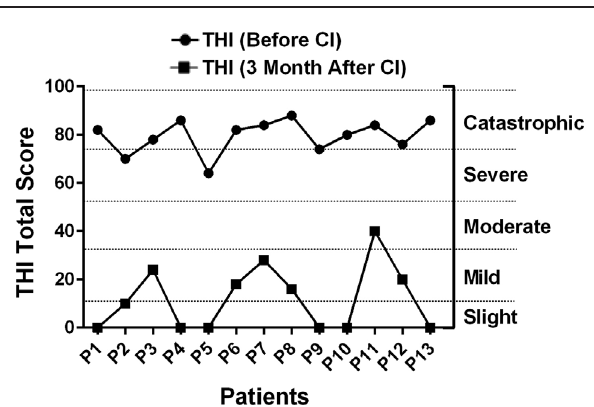
Tinnitus Handicap Inventory (THI) grading for each patient in the study group before and after cochlear implantation (CI).